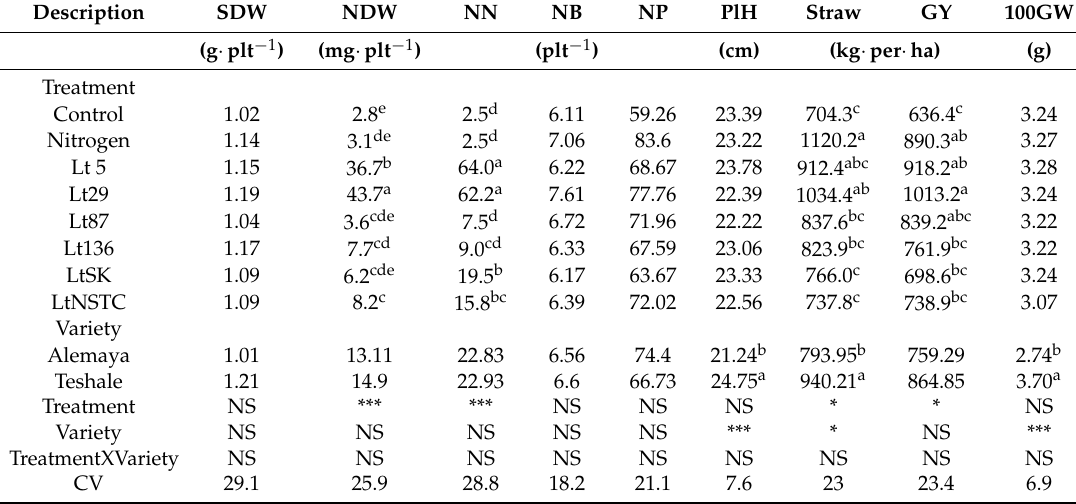
Table 3. Effect of Rhizobium inoculation and N fertilizer application on nodule number (NN), nodule dry weight (NDW), shoots dry weight (SDW), grain yield, and yield component in Huletegna Choroko soil under field